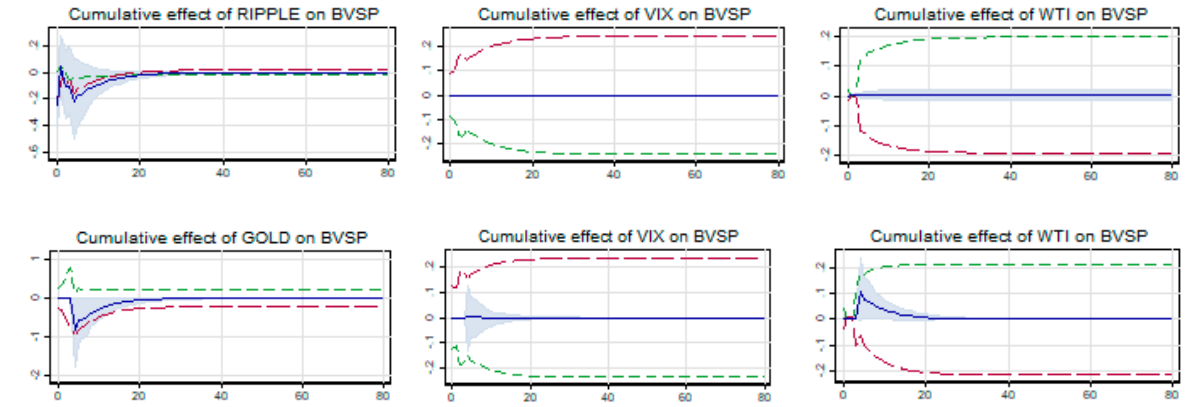
Figure 7. Cumulative effects of cryptos and gold on BVSP.